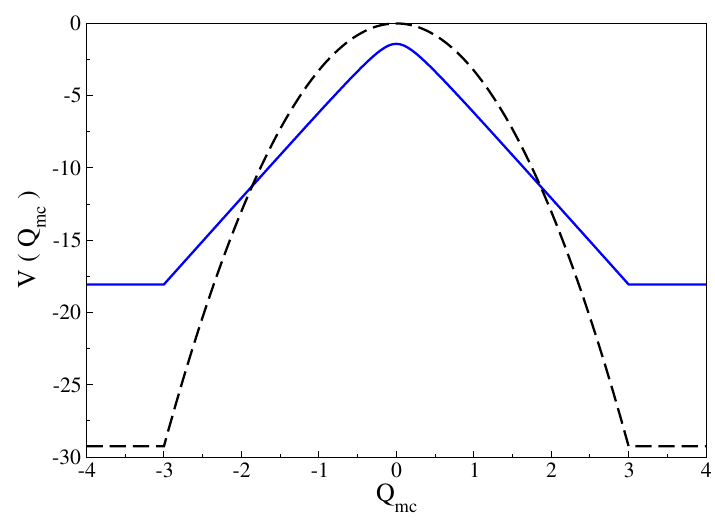
Figure 3 . Bias potentials adopted in the illustrative example discussed in the text. The continuous line refers to the potential in eq. (2.11), with a q = 3 : 25 and a cut-o(cid:11) at Q max = 3. The dashed line refers to the potential in eq. (2.12), with B = 6, C = 2 and a cut-o(cid:11) at Q max =